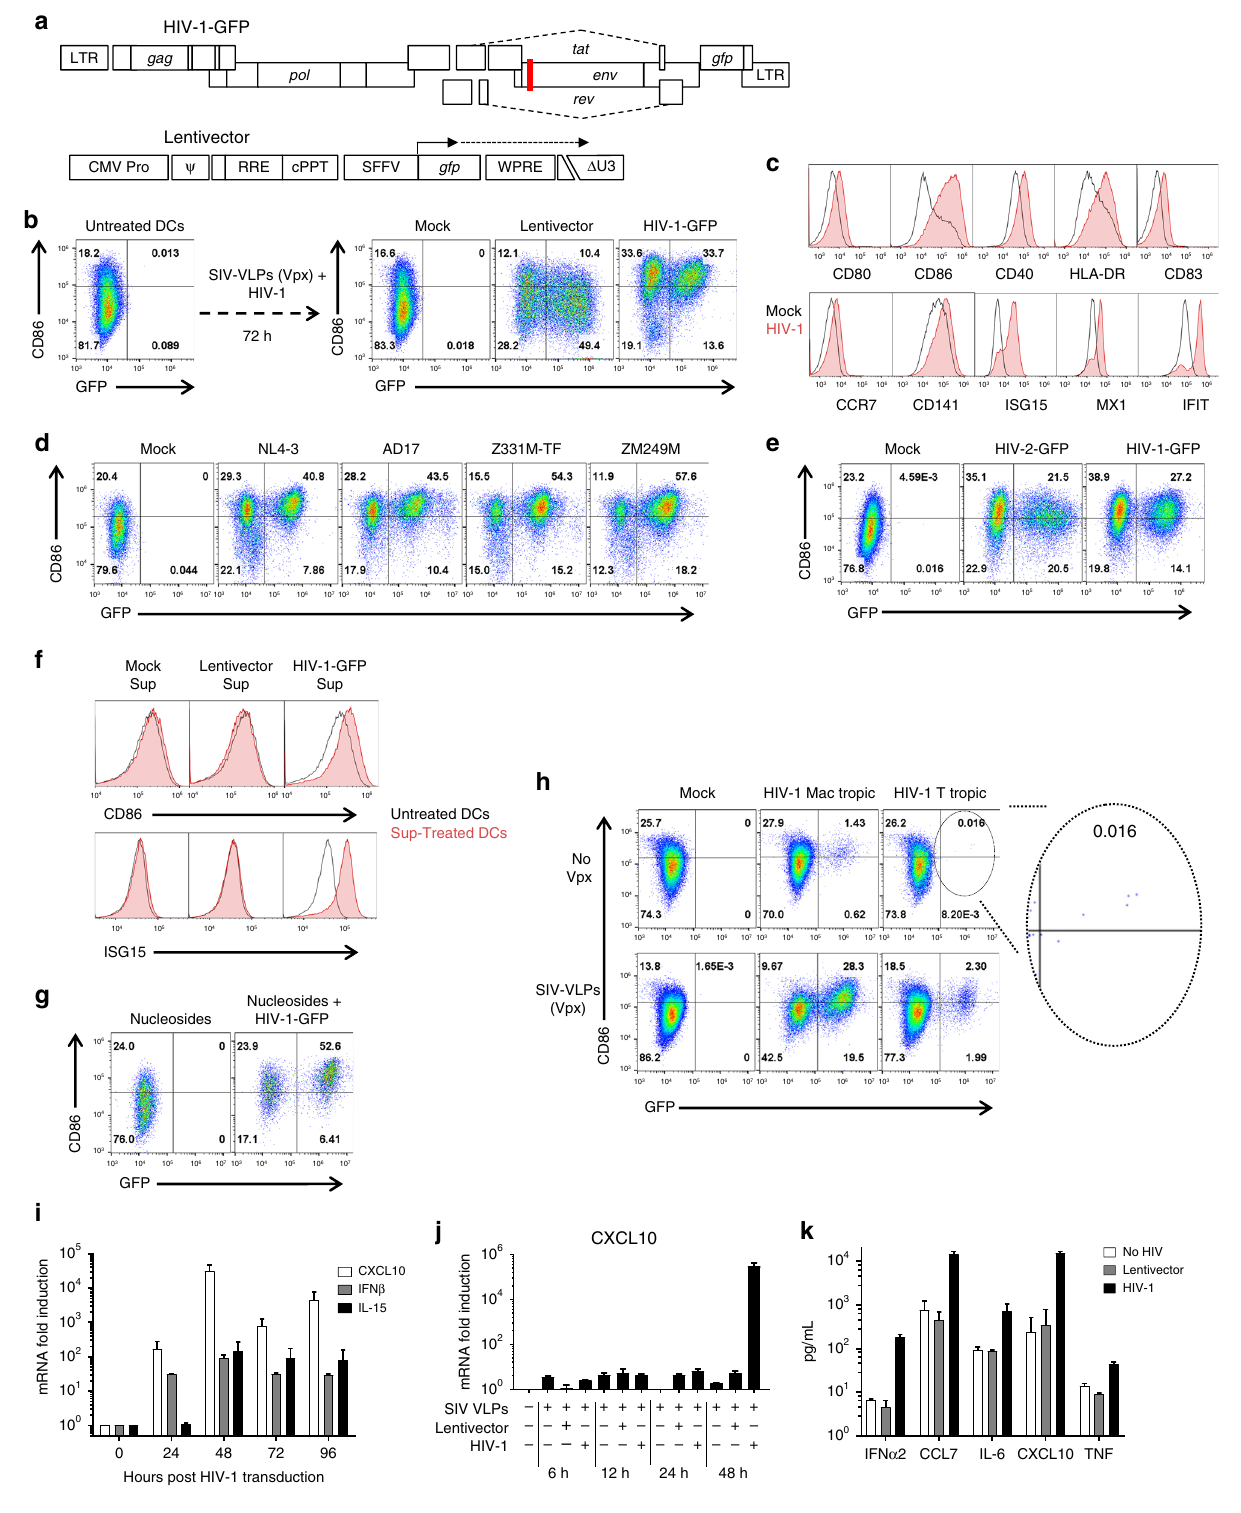
TBK1, IKKe, TAK1, or NLRP3 (Supplementary Table 2). Under the conditions used here, then, DC maturation required reverse transcription and integration but was independent of most well characterized innate immune signaling pathways. Provirus transcription is required for innate activation . Com- pletion of the HIV-1 integration reaction requires cellular DNA